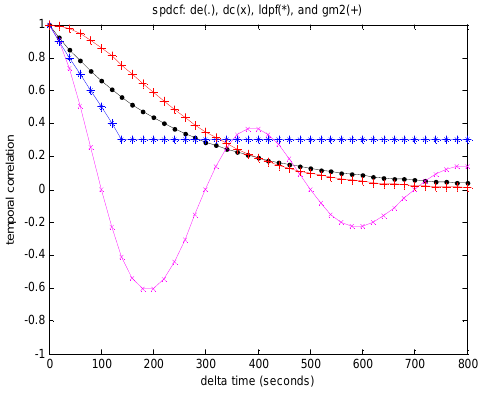
Figure 16. Four examples of spdcf